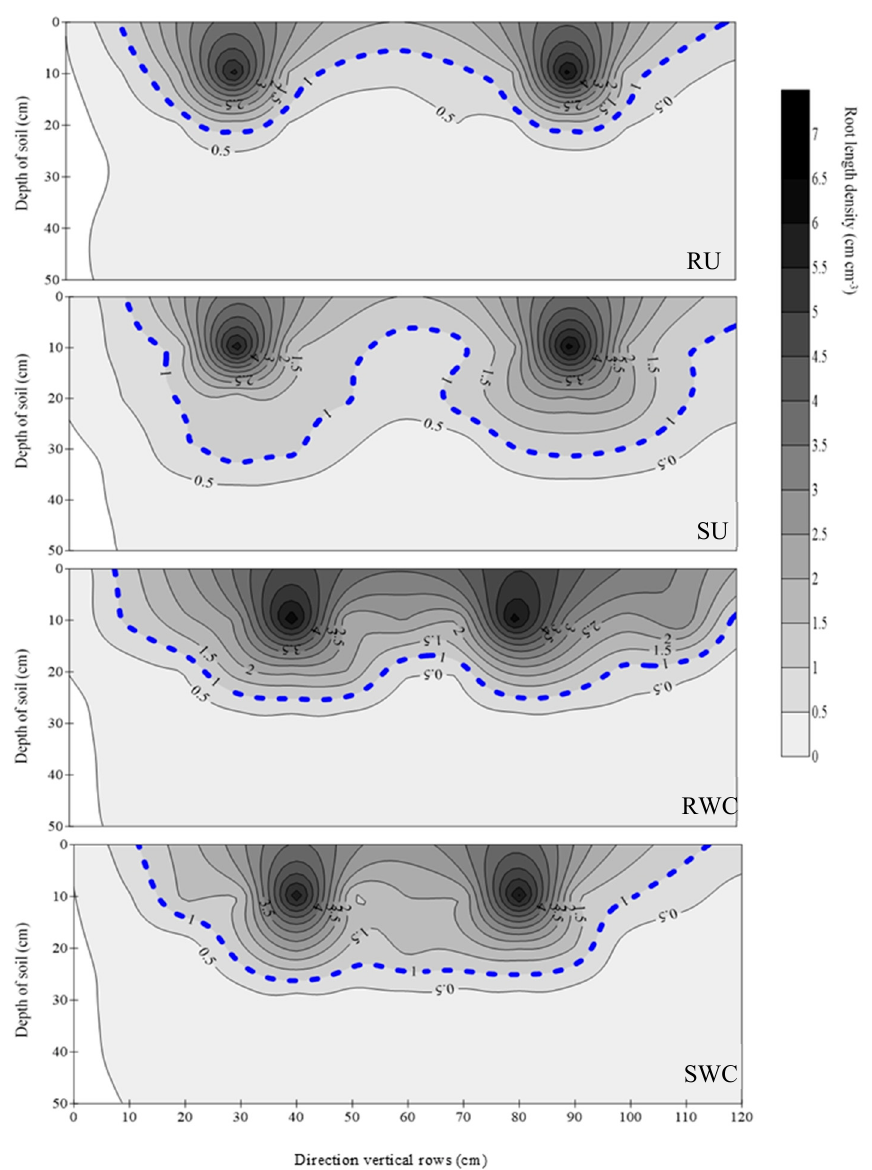
Figure 5. Spatial distribution of root length density in the 0–50 cm soil layer at R2 under different cultivation modes in 2014. RU, rotary tillage plus uniform plant spacing (CK); SU, subsoil tillage plus uniform plant spacing; RWC, rotary tillage plus wide–narrow plant spacing and chemical regulator; SWC, subsoil tillage plus wide–narrow plant spacing and chemical regulator application.